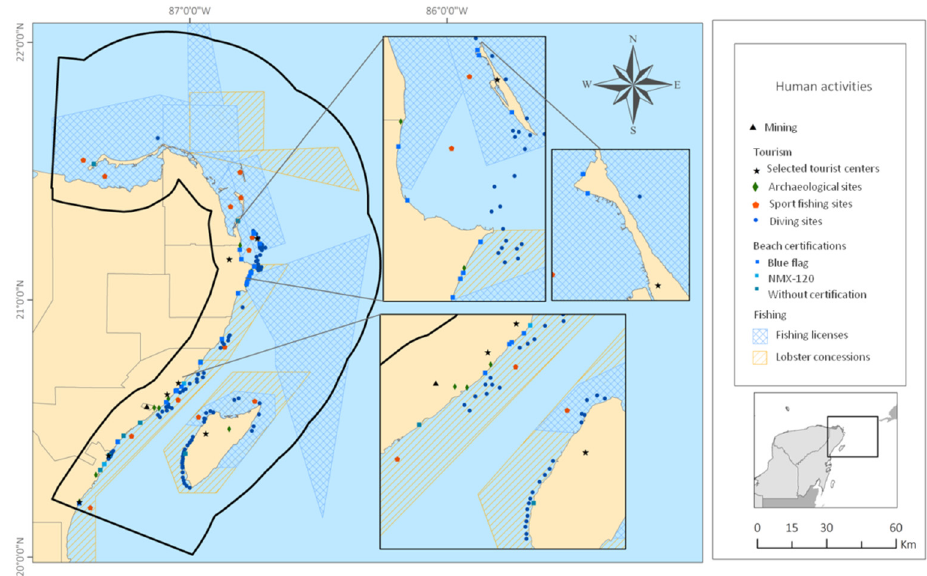
Figure 7 . Human Activities . Figure 7. Human